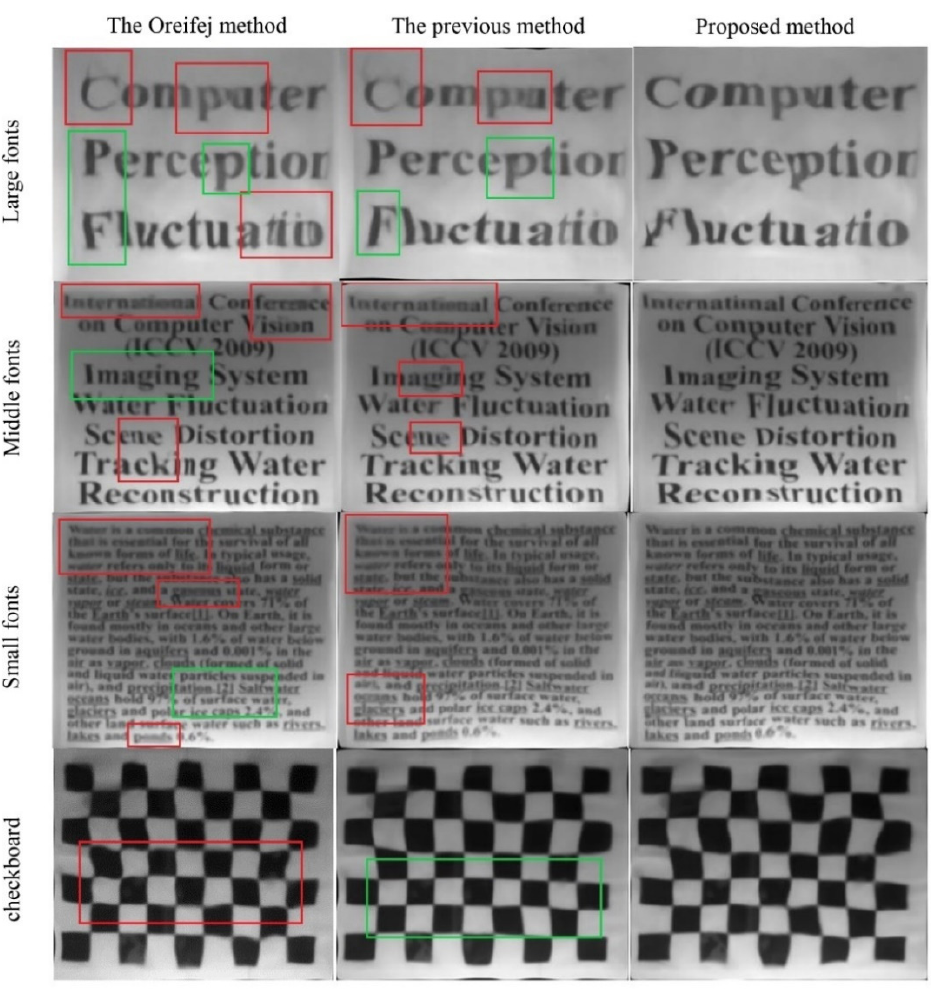
Figure 2. The recovery results of different methods after five iterations. The regions marked with red rectangles are inferior to our method. The green rectangles mark the regions with less distortion than our method.